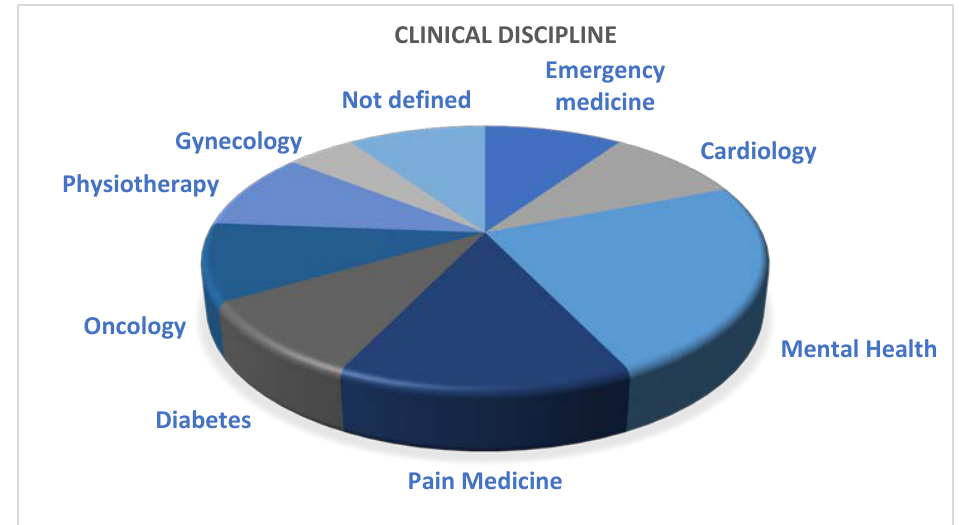
Figure 2. Clinical disciplines covered in the reviewed papers.